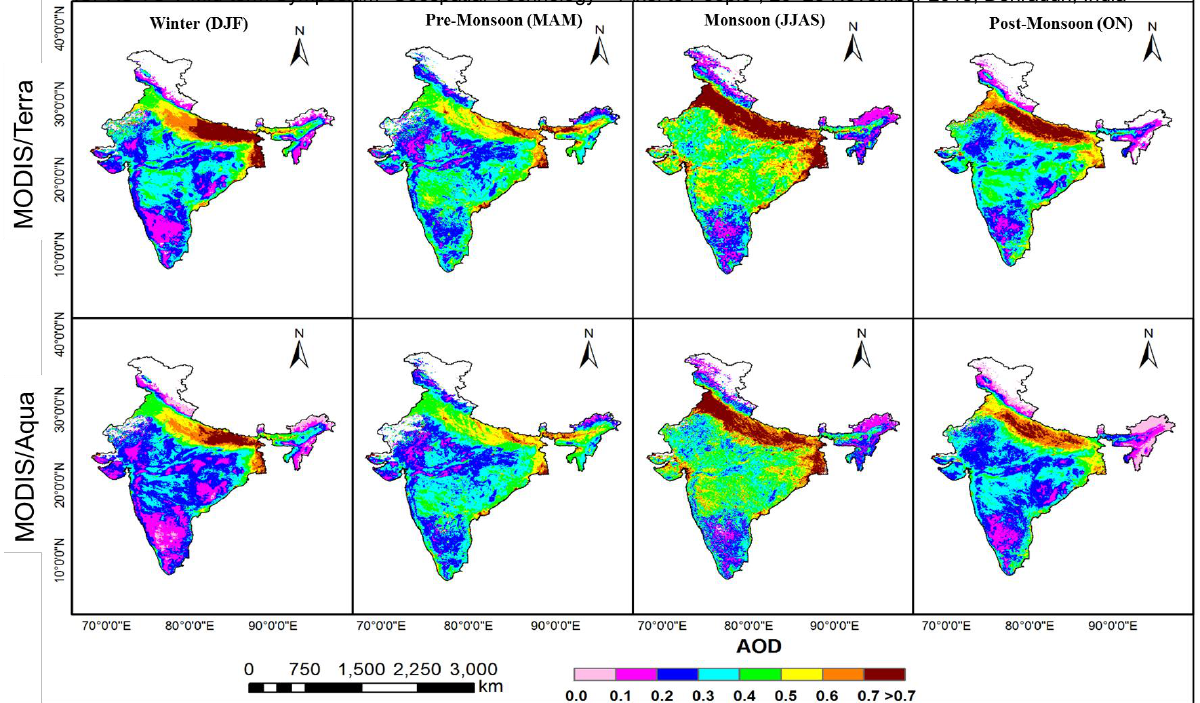
Figure 2. Seasonal spatial distribution of climatological (2001–2017) average AOD over the Indian based on MODIS 3-km Terra (top panel) and Aqua (bottom panel).